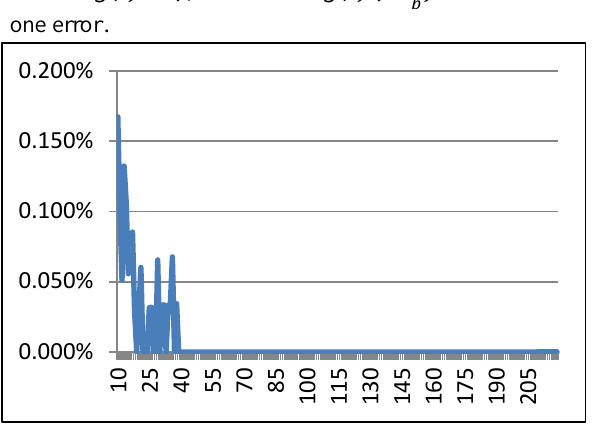
Fig. 5. Sequence length fixed with the verification part growing, the error percentage vertical axis: error percentage horizontal axis: the length of k From Fig. 5, when the verification part is greater than 4, the error percentage goes to zero.